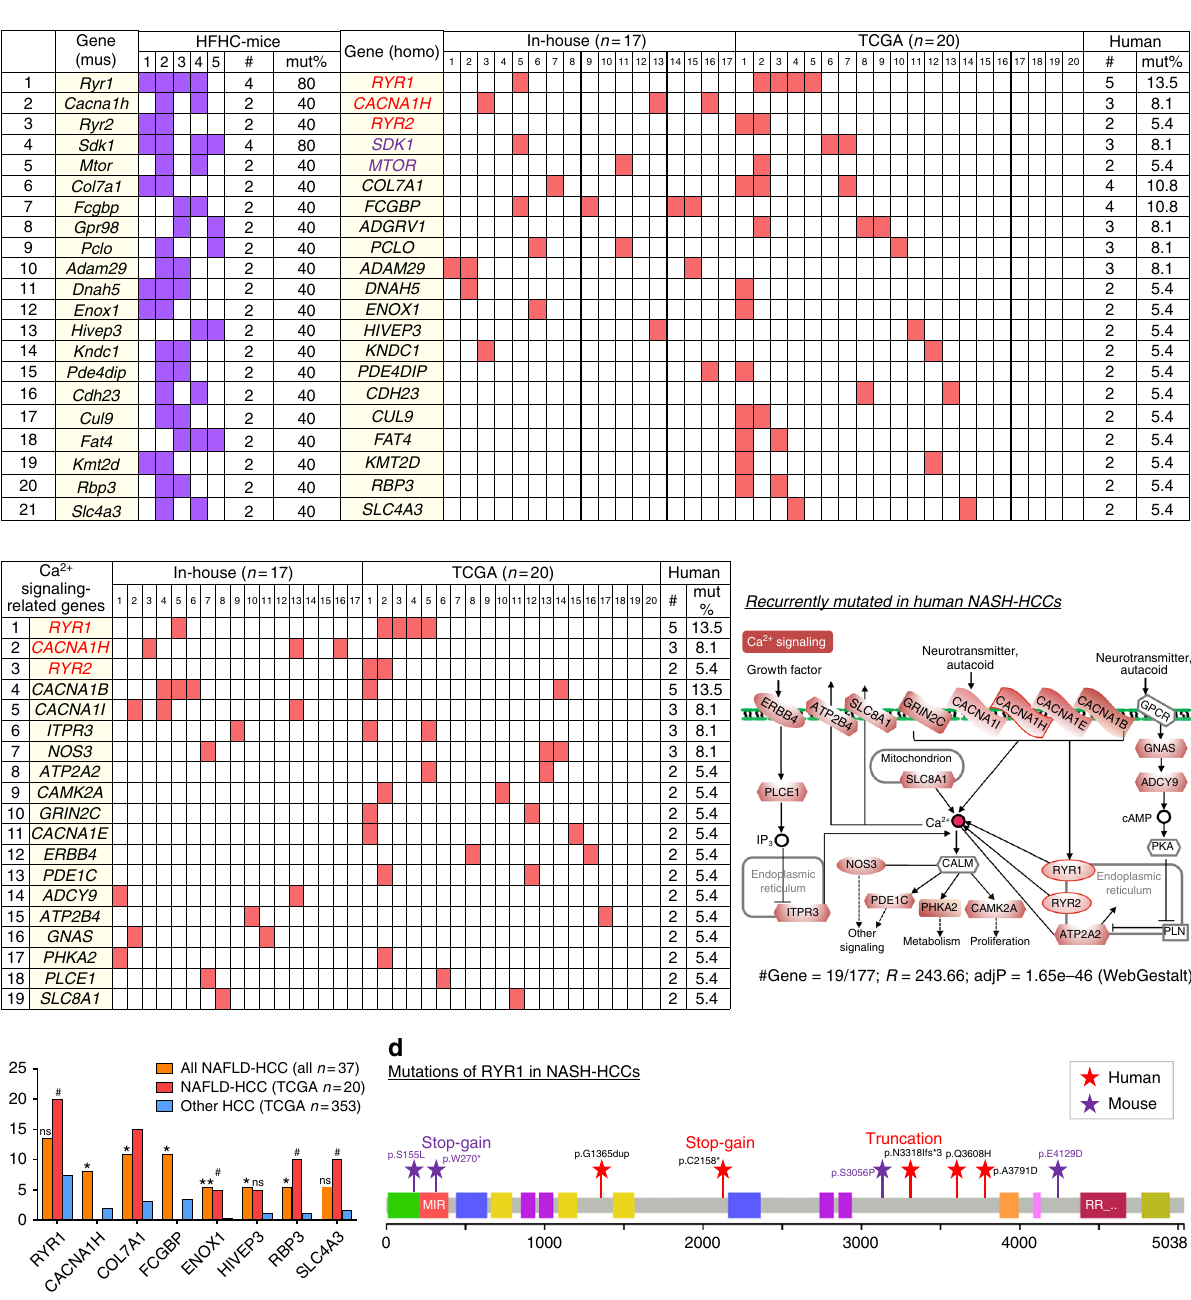
Fig. 7 Validation of recurrently mutated genes in human NASH-HCCs. a Recurrently mutated genes identi fi ed in mouse NAHS-HCCs were checked in 37 human NASH-HCCs (17 in-house and 20 from TCGA). Recurrent mutations in 21 genes were veri fi ed in human NASH-HCCs. b Recurrently mutated calcium signaling-related genes in human NASH-HCCs. c Mutation frequencies of eight genes were higher in HCCs with risk history of NAFLD than others without NAFLD (Chi-square test). * P < 0.05 and ** P < 0.001 for all NAFLD-HCCs (in-house and TCGA, n = 37) versus other HCCs; # P < 0.05 for NAFLD- HCCs from TCGA ( n = 20) vs. other HCCs; ns non-signi fi cant as compared with other HCCs. d Schematic illustration of the mutation sites in Ryr1 identi fi ed in mouse and human